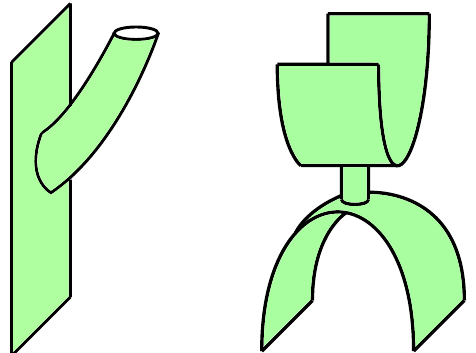
Figure 8 . Topology-changing Euclidean con(cid:12)gurations. Our quantization of the Jackiw-Teitelboim theory does not include such processes, consistent with what the Lorentzian path integral would predict. But perhaps it